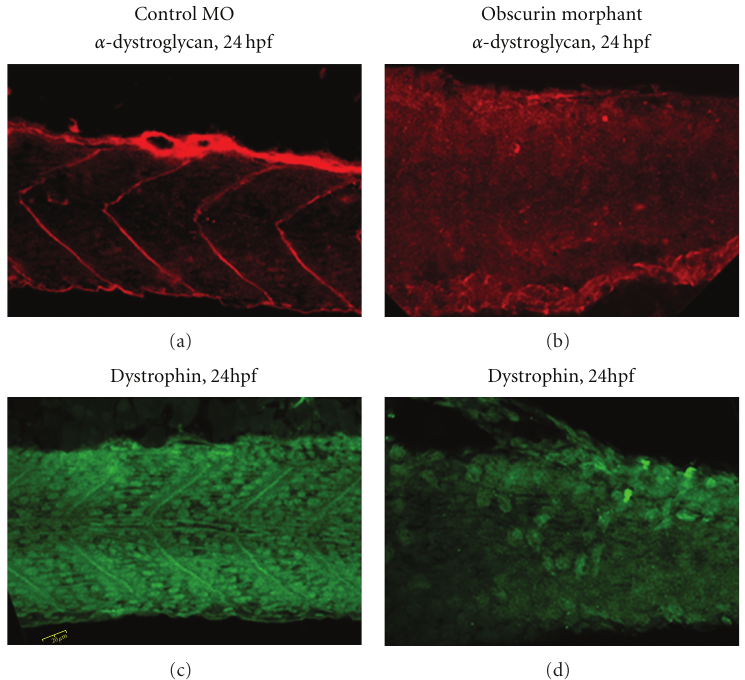
Figure 7: Obscurin depletion leads to marked reduction in localization of α -dystroglycan and dystrophin to the myotendinous junction. α - dystroglycan ( α -DG) (a), (b) and dystrophin (c), (d) are abundant at the myotendinous junctions (MTJ) in control (a), (c) but not obscurin morphant embryos (b), (d). Note that in the obscurin-depleted embryos, α -DG and dystrophin are not noted even in the disorganized MTJs of the targeted embryos suggesting a specific destabilization of dystrophin-associated glycoprotein complex (DGC) in response to decreased obscurin expression.